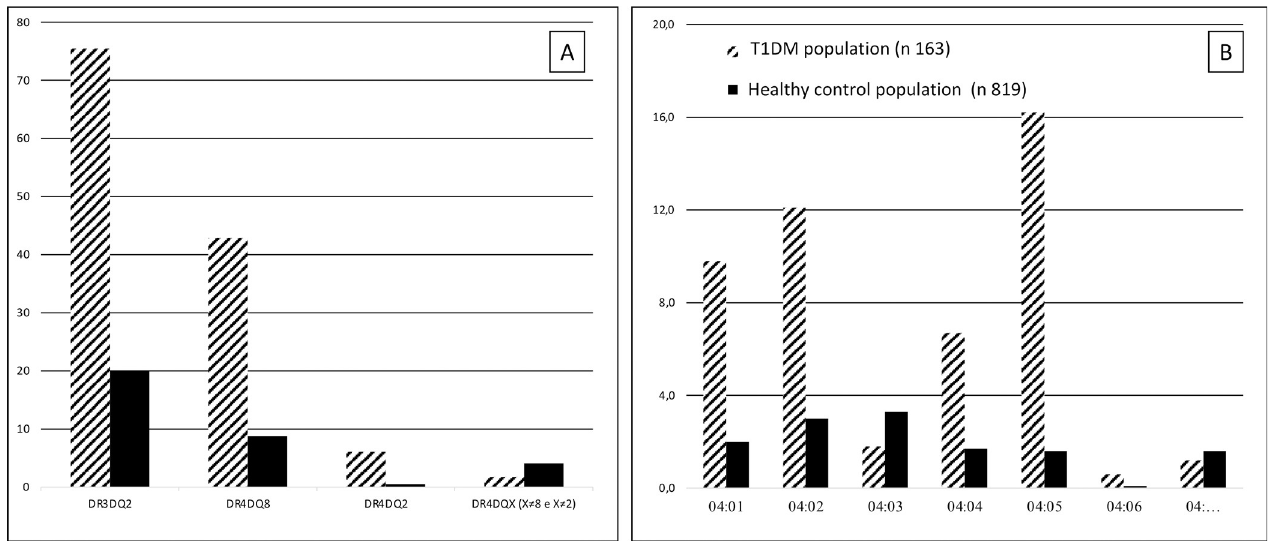
Fig 2. A) Comparison between the haplotypes of the T1DM population and those of the control population. B) Comparison of the DRB1 � 04 allelic variant of the study and control populations.